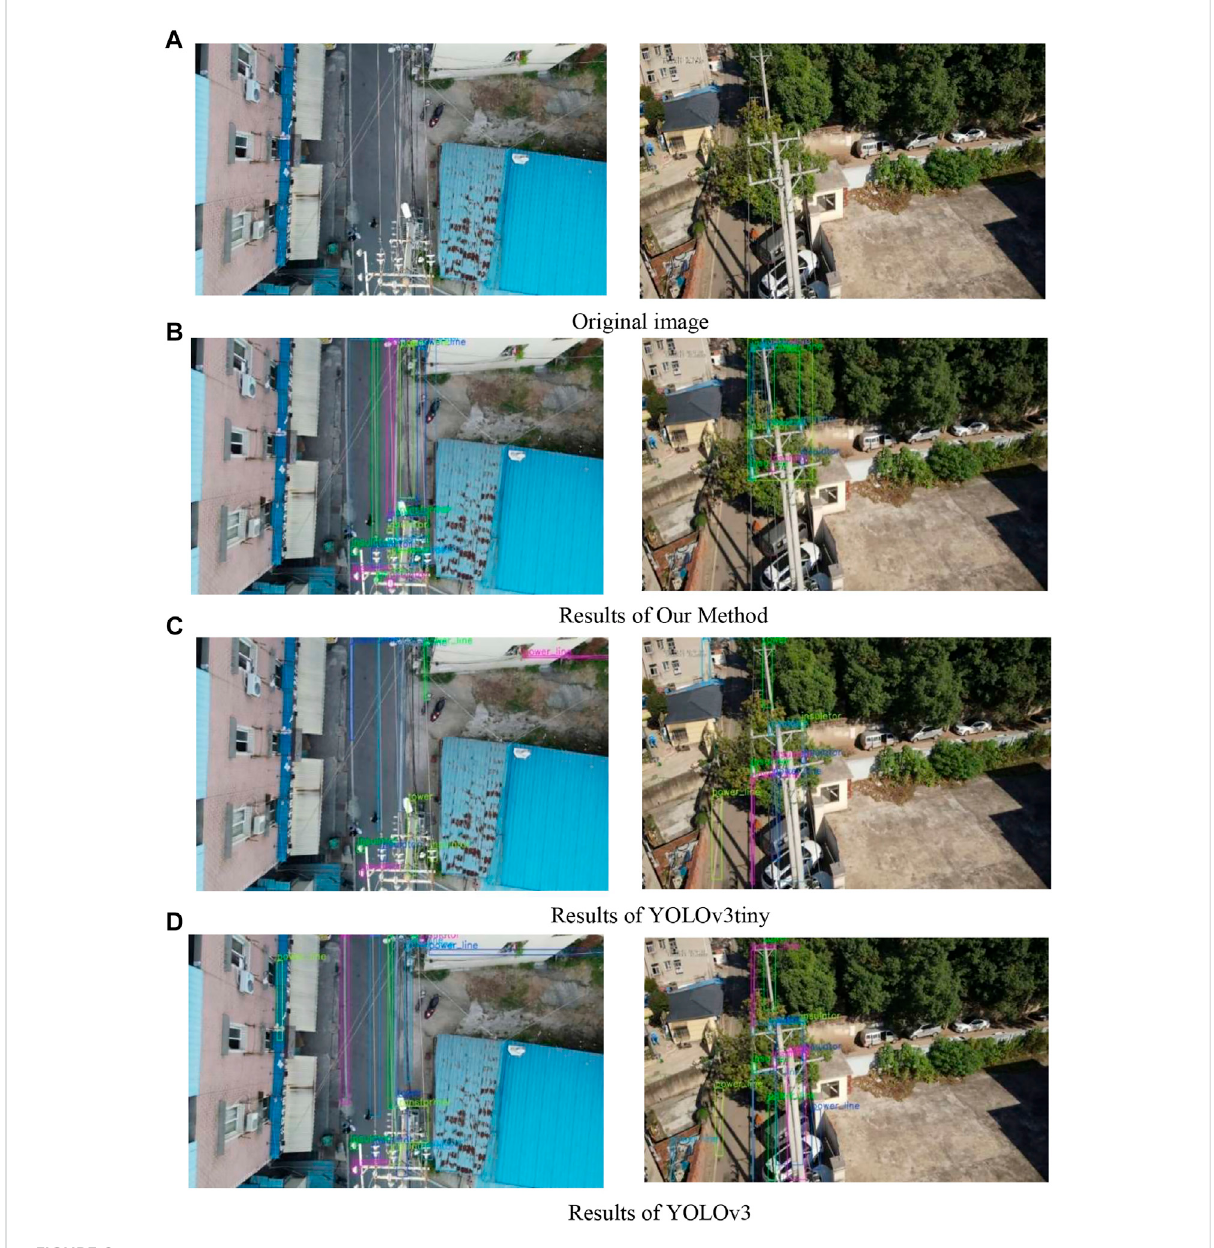
FIGURE 8 Results of various algorithms.